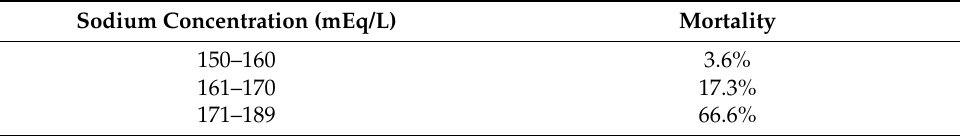
Table 1. Mortality rates associated with severity of hypernatremia